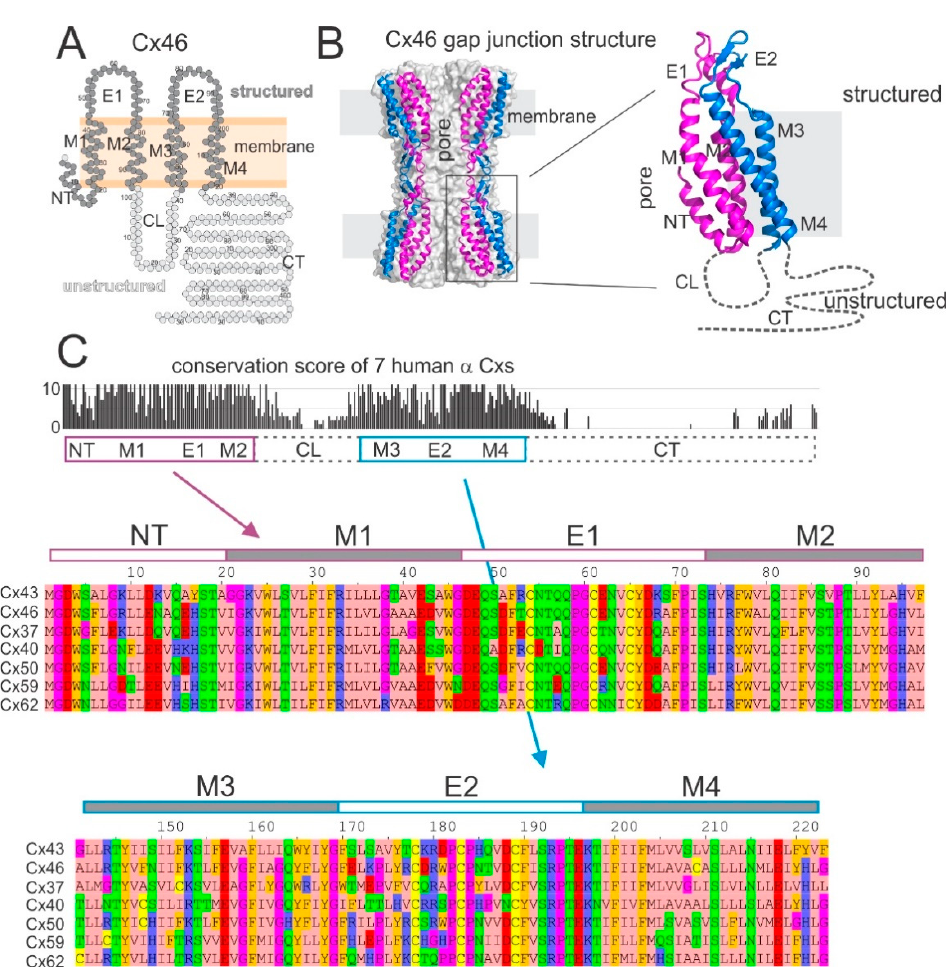
Figure 1. Gap junction structure and sequence alignment in structure resolved domains in α -connexins. ( A ) Topological structure of sheep Cx46 showing four transmembrane domains (M1–4), two extracellular loops (E1 and E2), one cytoplasmic loop (CL), amino terminus (NT), and carboxyl terminus (CT). The structured residues are colored in dark gray, and the unstructured residues are colored in light gray. ( B ) Sheep Cx46 gap junction structure (6MHQ) is shown in a cartoon representation with PyMOL [21]. Four connexin subunits out of 12 are shown (two on each side) to highlight the pore. Pore-lining domains (NT, M1, E1, and M2 or called pore domain) are colored in magenta and the domains on the periphery of the channel (M3, E2, and M4, called non-pore domain) are colored in blue. An enlarged view of a single Cx46 subunit is shown on the right to display the domains in structure-resolved domains and the structure-unresolved domains (CL and CT by dashed lines). ( C ) Structured domains are highly conserved among seven human α -connexins. Seven human α -connexins are aligned and they displayed high conservation in the structured domains on both the pore (magenta-colored box, including NT, M1, E1, and M2) and non-pore (blue-colored box, including M3, E2, and M4) domains using the conservation scores of Jalview [22]. Note only the beginning portion of the CT domain conservation is shown.